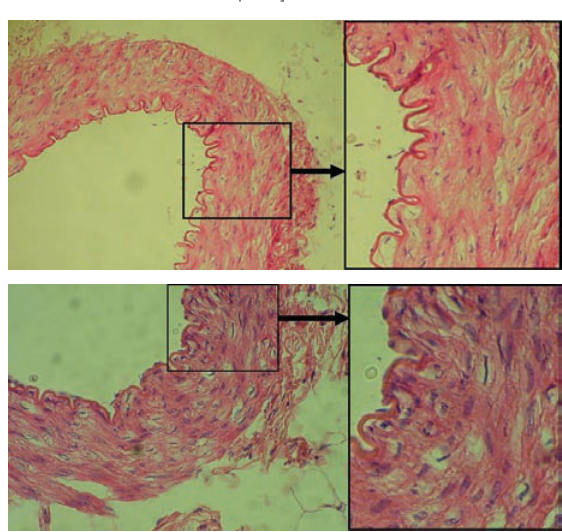
Figure 1, 2. Light microscopic examination of the coronary arteries of defibrillated dogs. No acute histo-pathological change typical of tissue injury was detected in the defibrillated dogs [Right panel is the magnified view of the left